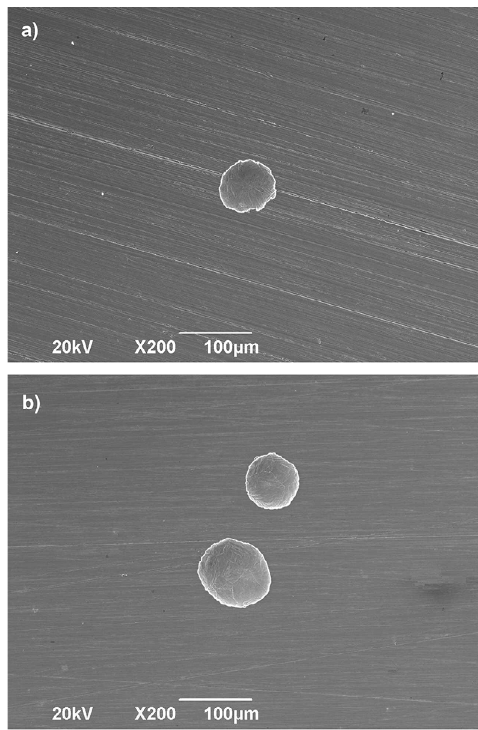
Figure 11. SEM images of pit morphology found at potentiodynamic polarization, conditions: (a) H950 and (b) H1000, 0.6M NaCl + 0.06M Na2SO4 electrolyte. amount of austenite, diminuish of chi phase and coarsening of Ni Ti 3